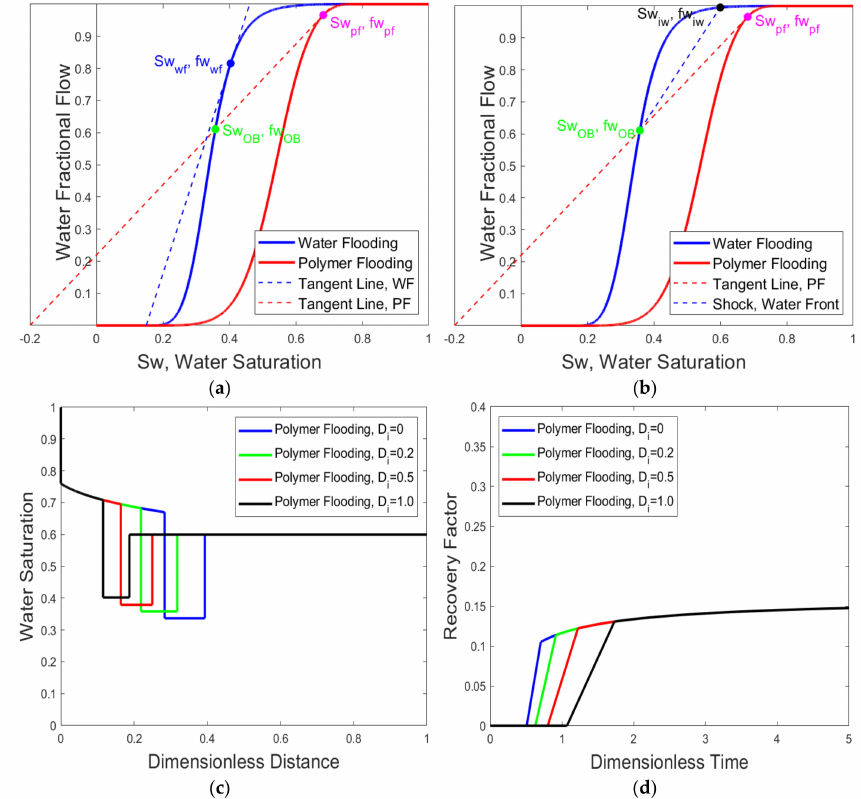
Figure 19. ( a ) Comparison of shock front for water flooding and polymer flooding; ( b ) Construction of shock front during tertiary polymer flooding; ( c ) Saturation profile at t D = 0.20 PV during tertiary polymer flooding; and ( d ) Incremental oil recovery history during tertiary polymer flooding at a di ff erent retardation